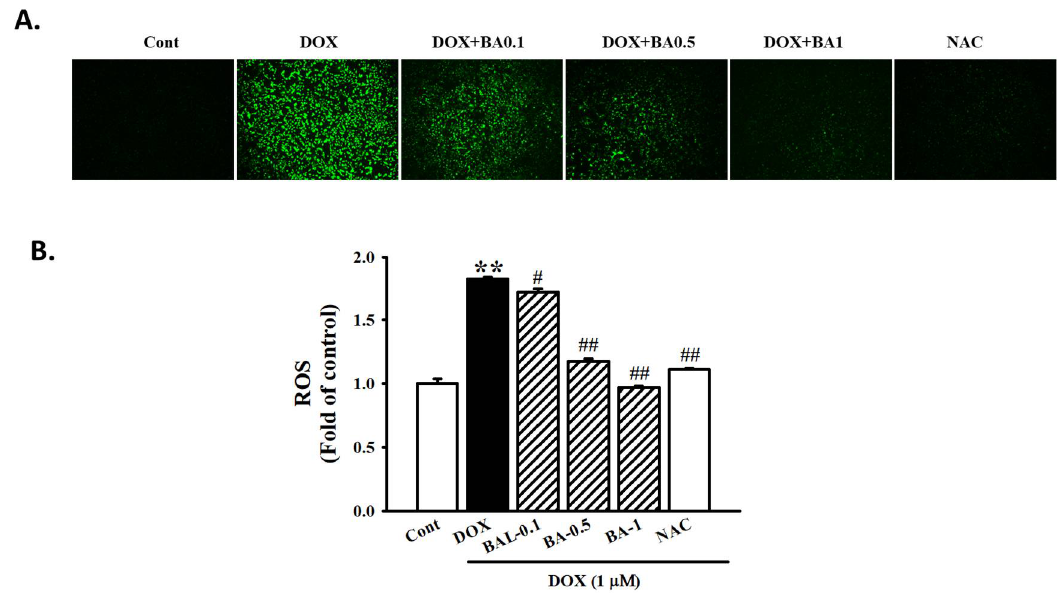
Figure 4. Effect of BA on ROS formation in DOX-induced cardiac hypertrophy. ( A ) Analysis of ROS formation using DCFH-DA staining on H9c2 cells treated DOX and pre-administration of BA after 30 min of treatment. ( B ) Alternatively, the relative ROS levels were quantified by fluorescence microplate. The images were taken using light (magnification 20 × ). All experiments were performed at least three times. Data represent mean ± SD. ** p < 0.01, vs. control; # p < 0.05, ## p < 0.01, vs. DOX-treated